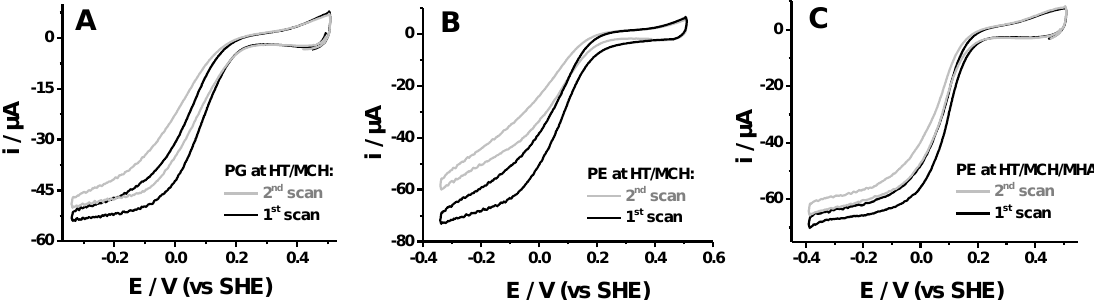
Figure 2. Two consecutive voltammograms obtained for cytochrome bd oxidase with 2.5% added PG on gold NPs modified with HT / MCH (1 / 1), ( A ) cytochrome bd oxidase with 2.5% added PE on gold NPs modified with HT / MCH (1 / 1) ( B ) and cytochrome bd oxidase with 2.5% added PE on gold NPs modified with HT / MCH / MHA (1 / 1 / 1) ( C ).